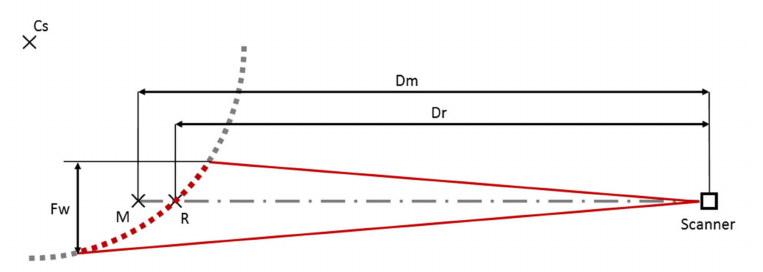
Figure A1. Top view sketch of the simulation of footprint size impact to the DBH estimate. Cs is center of stem, grey points represent the stem surface, red points represent the stem surface covered by a single laser beam. Red lines show laser beam divergence, Fw is laser footprint width. Dr. is real distance from the scanner to the center of laser beam on the stem surface. Dm is measured distance from the scanner, computed as the mean distance of all red points to the scanner. M is the location of simulated point. R is the location of center of the laser beam footprint.